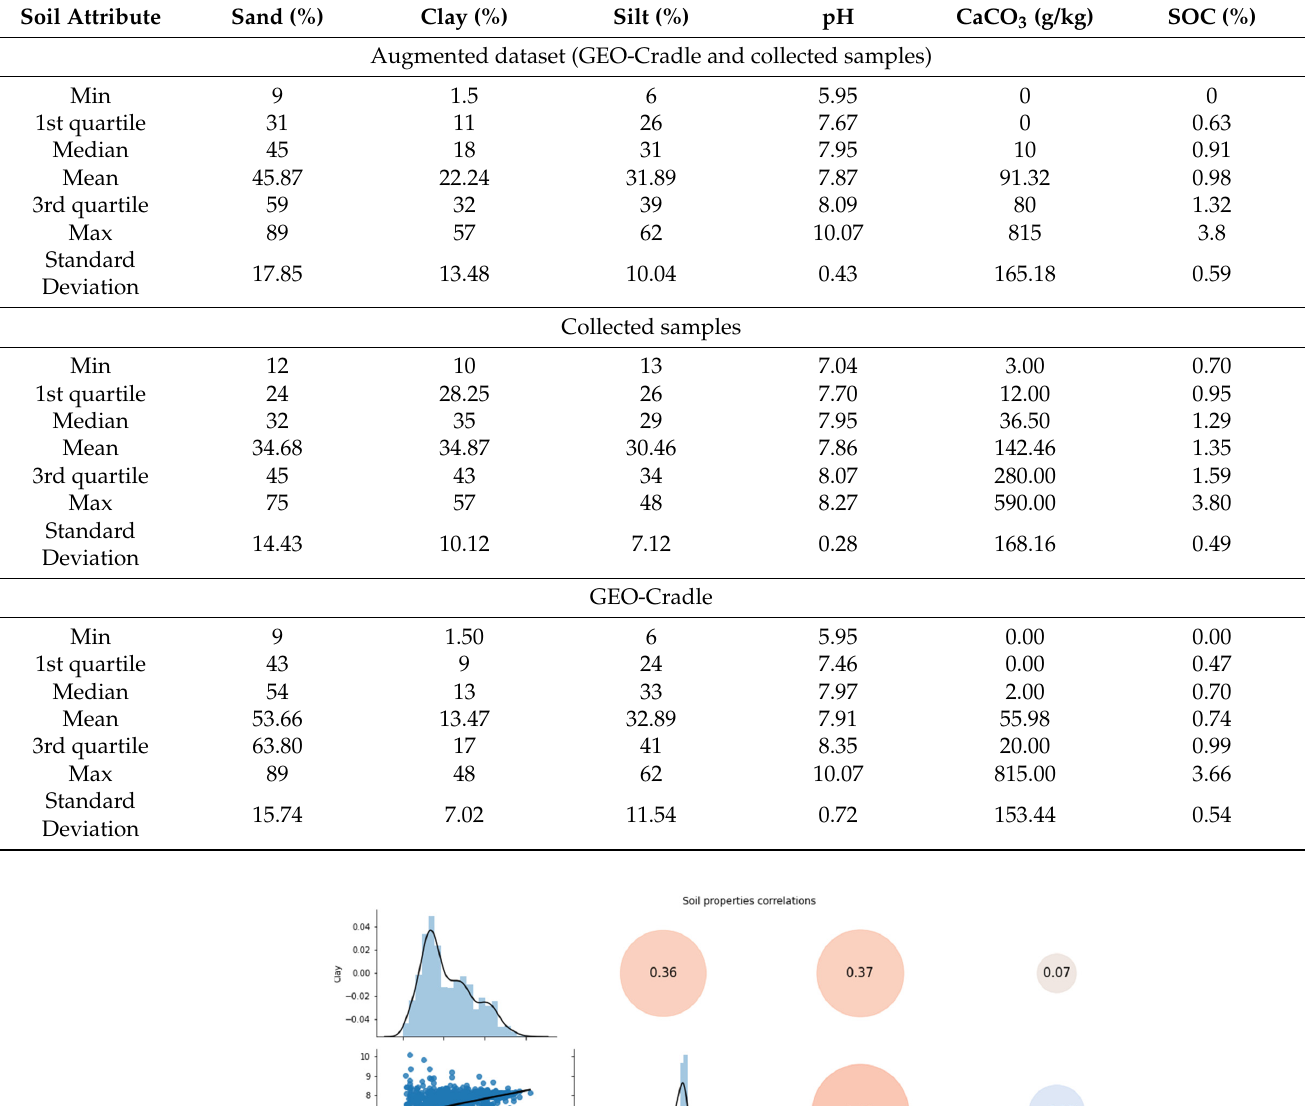
Table 1. Descriptive statistics of the chemical analyses for the augmented dataset, GEO-Cradle, and the collected samples.